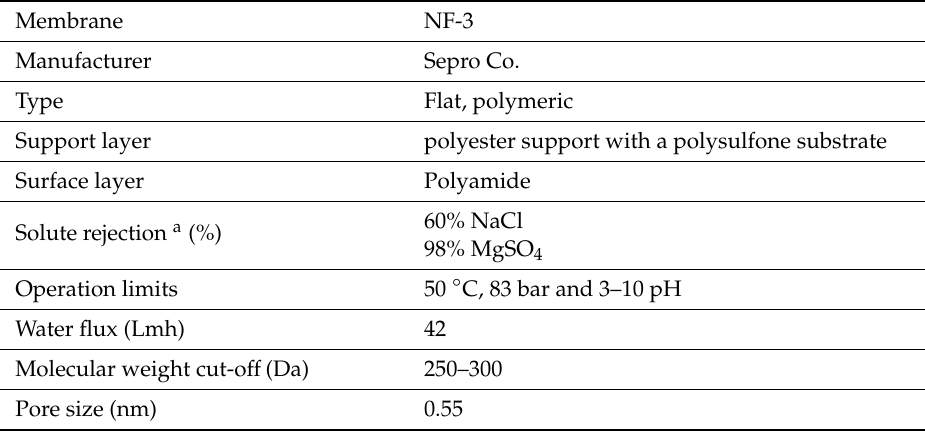
Table 3. Properties of NF-3 Nanofiltration Membrane supplied by the manufacturer.